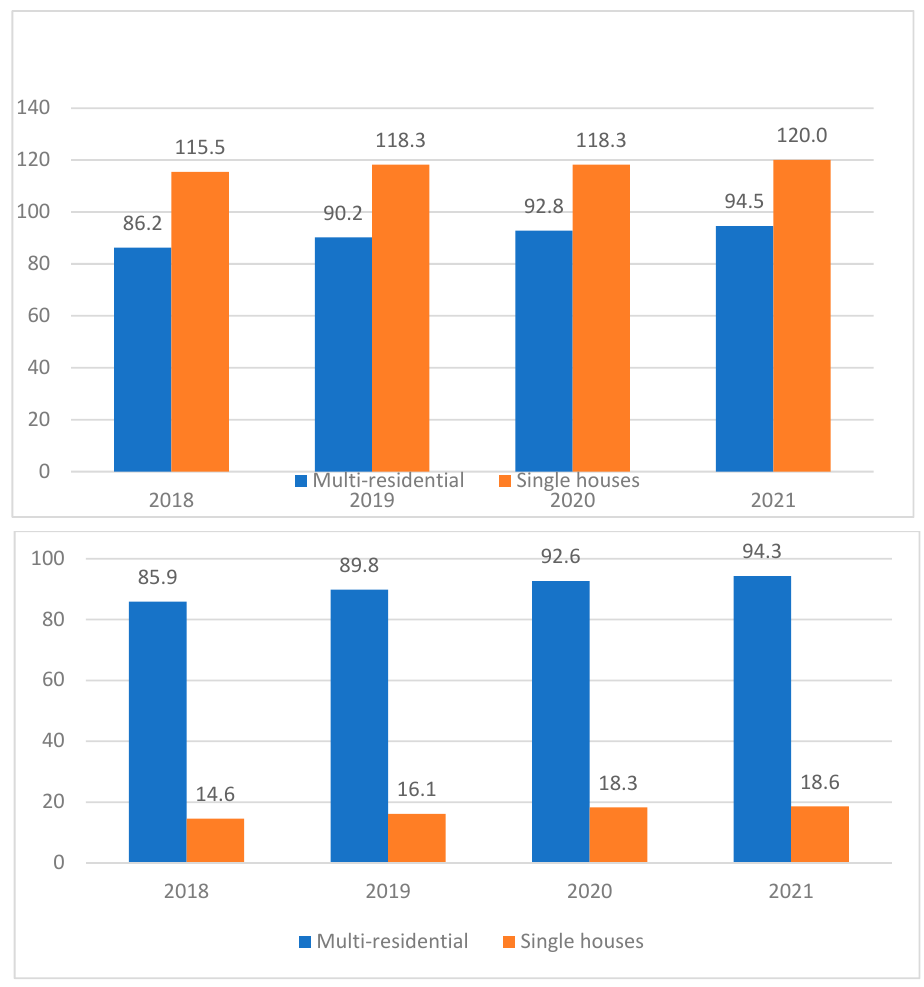
Figure 3. ( upper figure ) Water usage in April in thousands m 3 ; ( lower figure ) Total charged amount of wastewater for April month in thousands m 3.